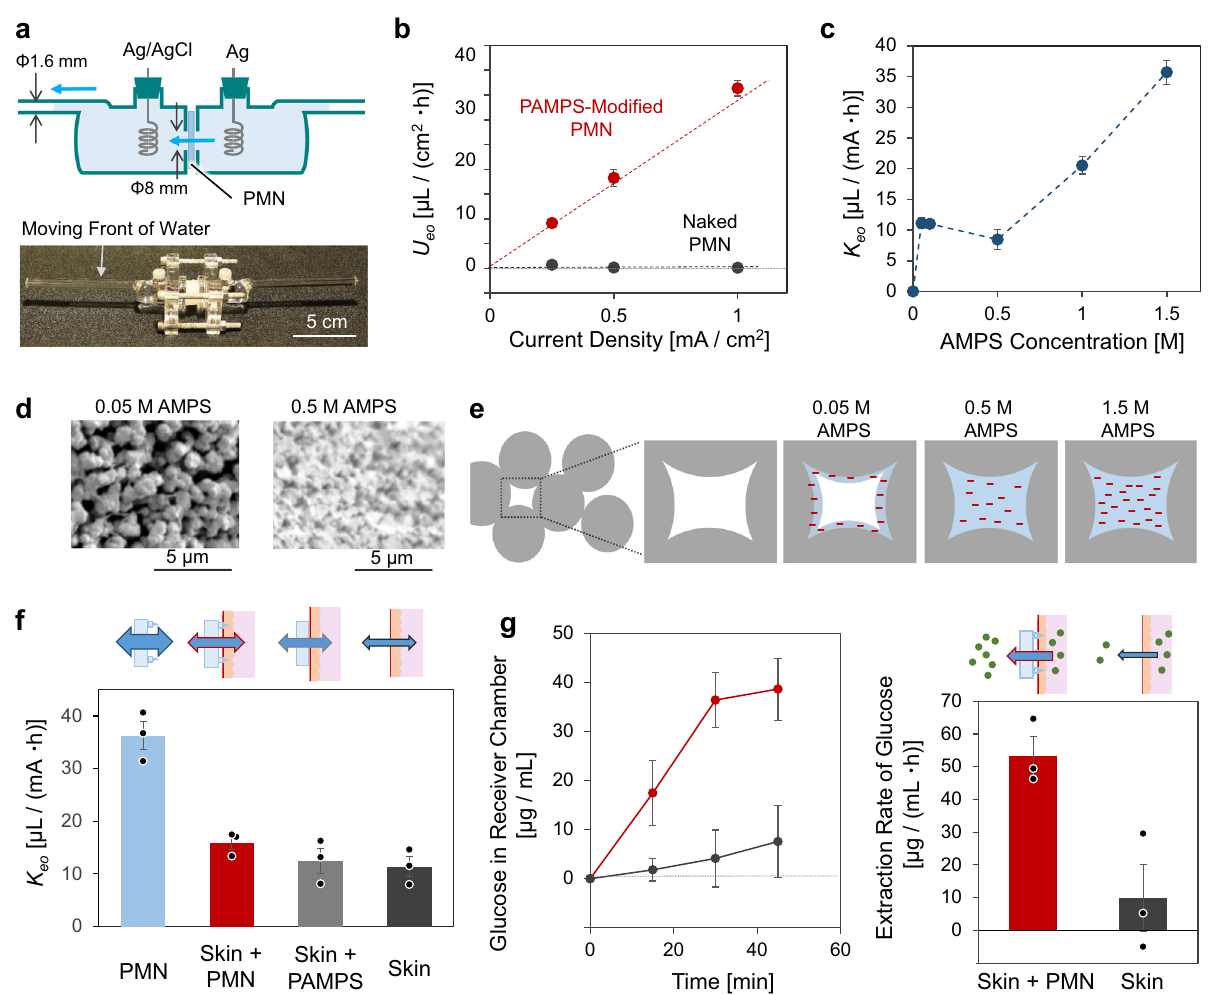
Fig. 3 Transport of water and small molecules. a A side-by-side Franz cell for measurement of the fl ux of water transport through a PMN under DC current application. b The fl ow velocity of EOF as a function of current density applied for a naked PMN (black) and a PAMPS- fi lled PMN prepared from 1.5 M AMPS (red) ( N = 3 independent experiments; mean ± SD). c The plot of K eo (slope of U eo vs. current density) against the AMPS concentration used for the modi fi cation of PAMPS ( N = 3 independent experiments; mean ± SD). d Representative SEM images of cross sections of PMNs modi fi ed with PAMPS made from 0.05 and 0.5 M AMPS ( N = 3 independent experiments). e Schematic illustration of pores in the PMN modi fi ed with PAMPS from various (cid:1) (cid:3) concentrations of AMPS. f The EOF strength K eo through a PAMPS- fi lled PMN made from 1.5 M AMPS (blue), a pig skin with the PMN (red), a pig skin with the PAMPS- fi lled porous PGMA plate (gray bar) and an intact skin (black) ( N = 3 independent experiments; mean ± SD). g The time-course of glucose concentration in receiver chamber (plot) and the rate of extraction of glucose (bar) from the intact skin (black) and the skin with the PAMPS- fi lled PMN (red) ( N = 3 independent experiments; mean ± SD). pH 7 McIlvaine buffer was